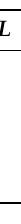
Table 3. Validity and fit indices for the pcMEL and baMEL SEMs. GoF, goodness-of-fit; APC, average part coefficient; ARS, average R 2 ; AVIF, average variance inflation factor; AFVIF, average full collinearity